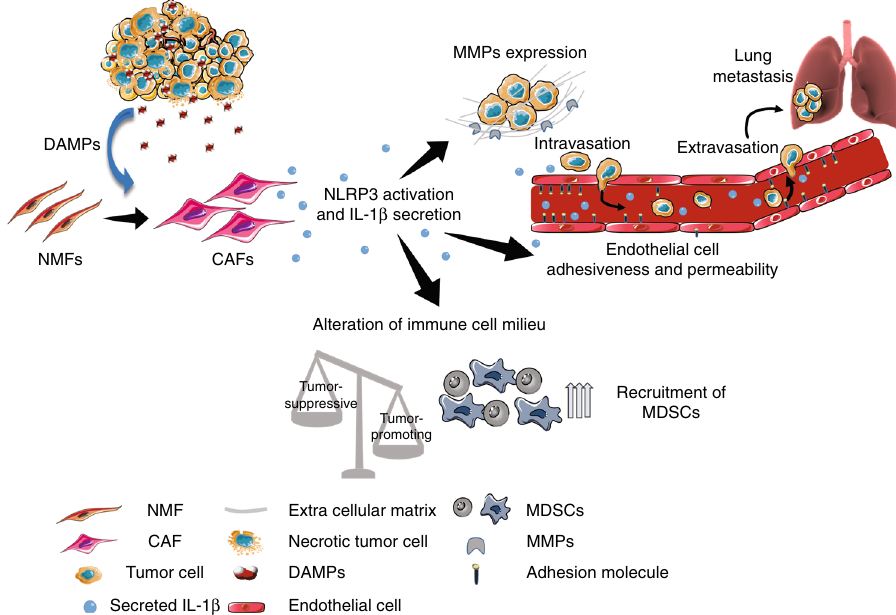
Fig. 7 Summary. Activation of the NLRP3 in fl ammasome in cancer-associated fi broblasts links tissue damage with tumour-promoting in fl ammation in breast cancer progression and metastasis. Figure preparation partially involved elements from the Servier Medical Art. Figure preparation involved using elements from the Servier Medical Art and somersault18:24